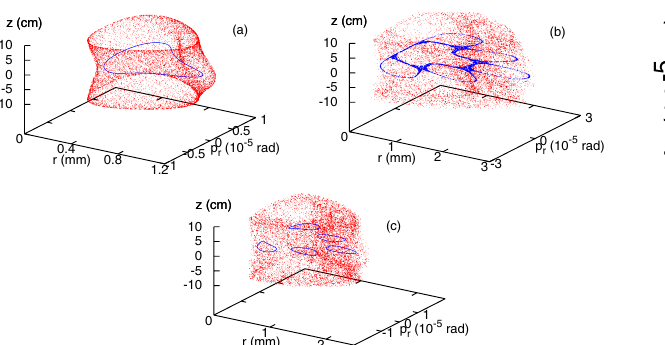
FIG. 7. (Color) Poincare´ plot in r (cid:1) p integrable ( (cid:12) (cid:5) 0 : 27 ), (b) stochastic ( (cid:12) (cid:5) 0 : 27 ), (c) stochastic ( (cid:12) (cid:5) 0 : 13